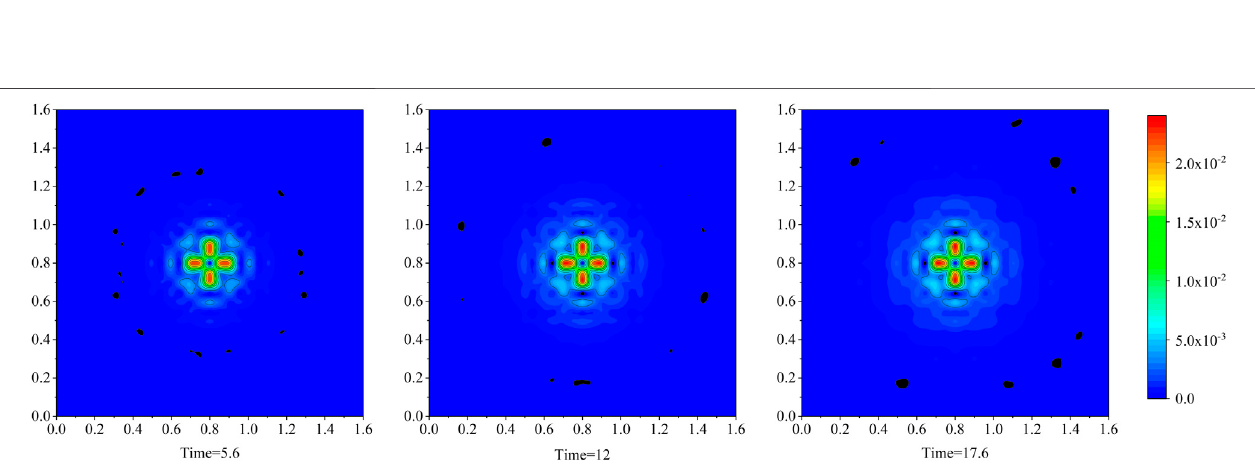
FIGURE 3 | The relative error graph of numerical solution and fi ne